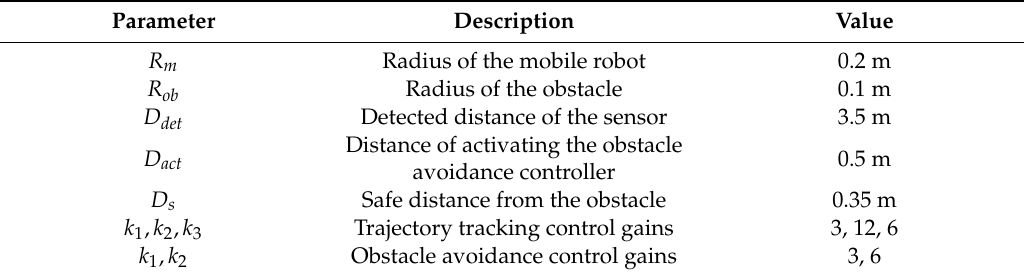
Table 1. Parameters used in two simulations